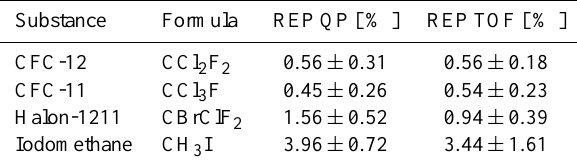
Table 6. The reproducibility (REP) for the QP MS and the TOF MS as a mean value of five measurement series with 20 measurements each and a preconcentration volume of 0.28L. The given errors are 1 σ standard deviation over five reproducibility experiments.